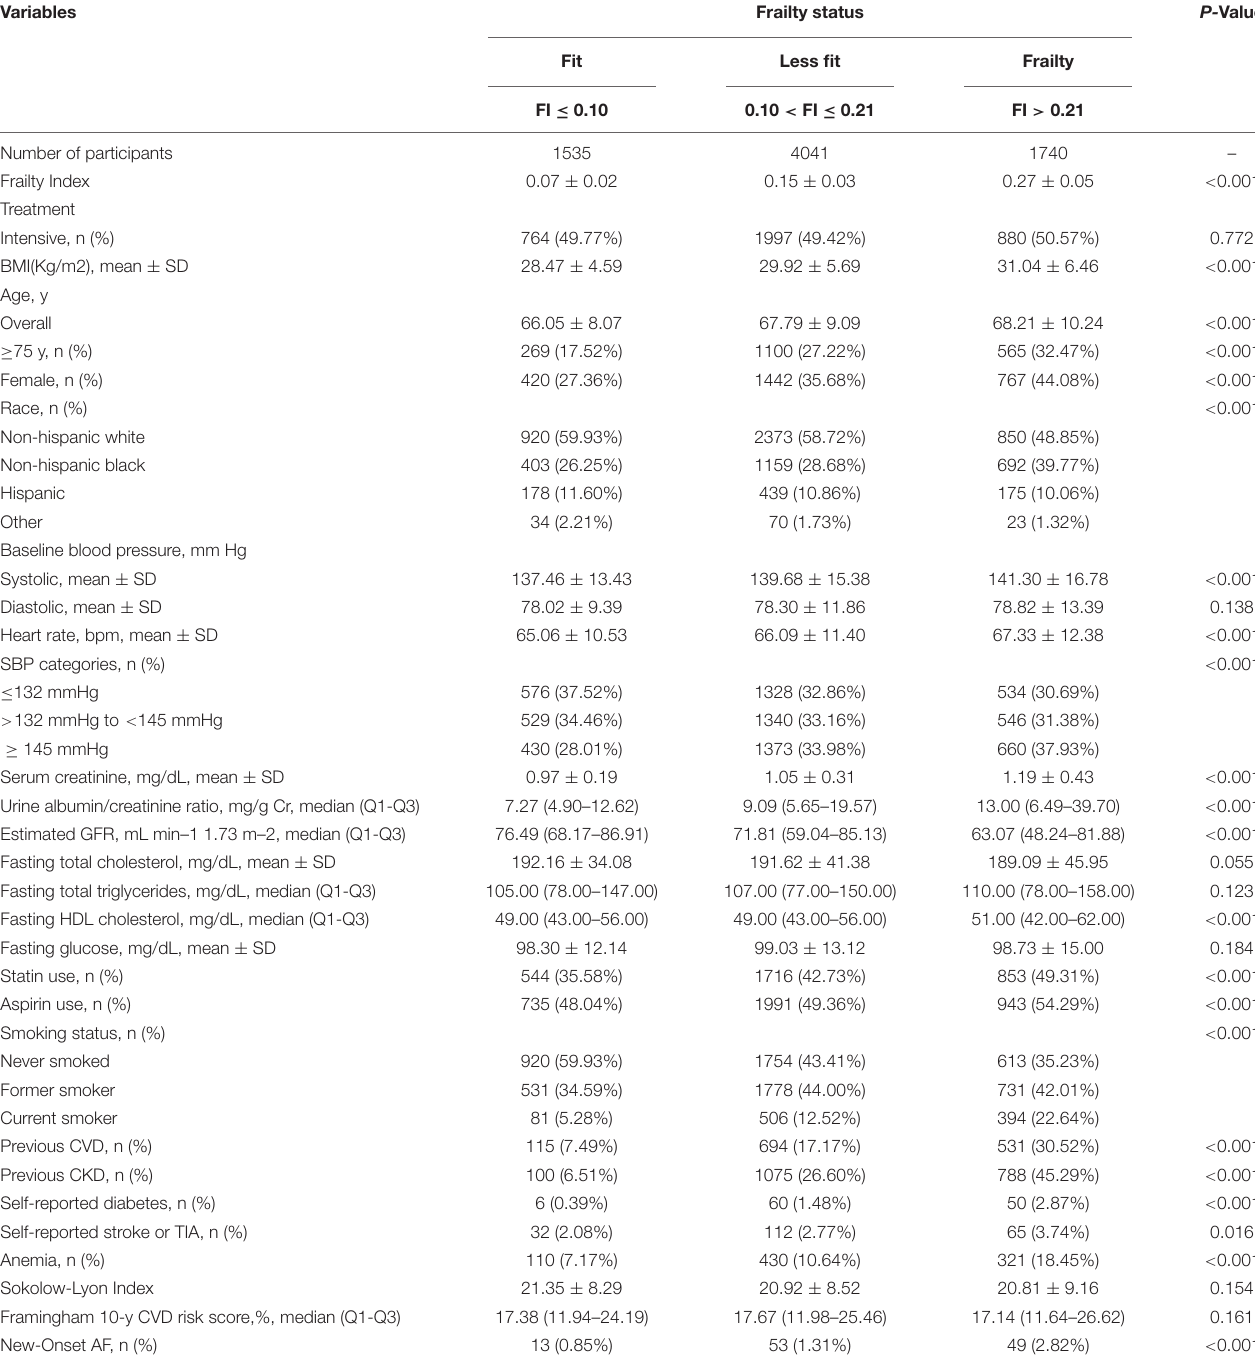
TABLE 1 | Baseline characteristics and crude outcome of the Systolic Blood Pressure Intervention Trial (SPRINT) participants by baseline frailty status. Variables Frailty status P-